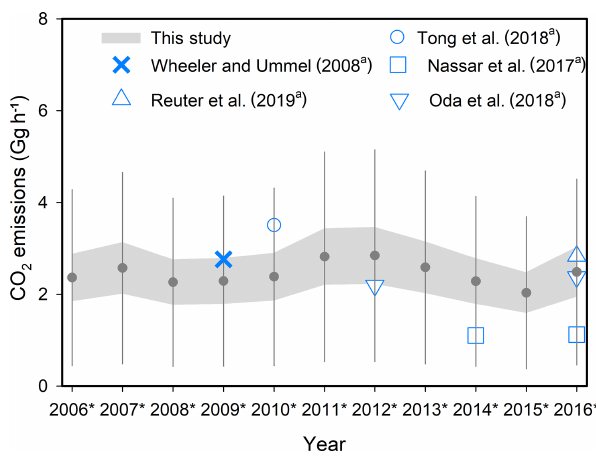
Figure 11. Comparison of E Sat (Ggh − 1 ) derived in this study, CO 2 with existing estimates for the Matimba power plant during 2005 to 2017. E Sat is inferred based on the NO x to CO 2 emissions ratio CO 2 + standard deviation of ranging from ratio CEMS to ratio CEMS regressed regressed ratio. The upper and lower grey bands denote the emissions inferred + standard deviation of ratio, from ratio CEMS and ratio CEMS regressed regressed respectively. The grey dots and error bars show the mean of the upper and lower grey bands and their uncertainties, respectively. a Emissions are estimated for 2009 by Wheeler and Ummel (2008), for 2010 by Tong et al. (2018a), for 2014 and 2016 by Nassar et al. (2017), for 2016 by Reuter et al. (2019), and for 2012 and 2016 by Oda et al.